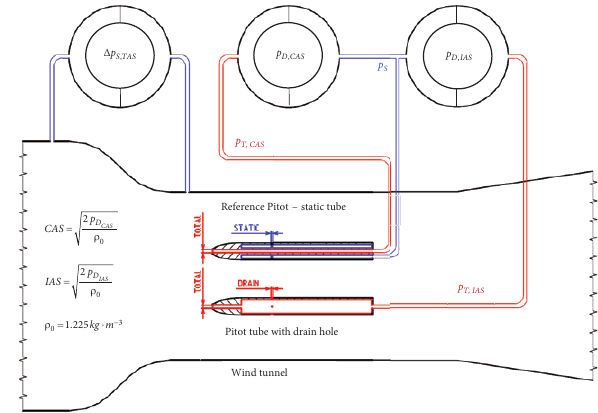
Figure 3. The wind tunnel test section with probes and pressure sensors connection (scheme not to scale: pitot static tube diameter is 4 mm, the drain hole pitot tube diameter is 10 mm and the test section is 500 × 700 × 2000 mm. The wind tunnel blockage ratio is